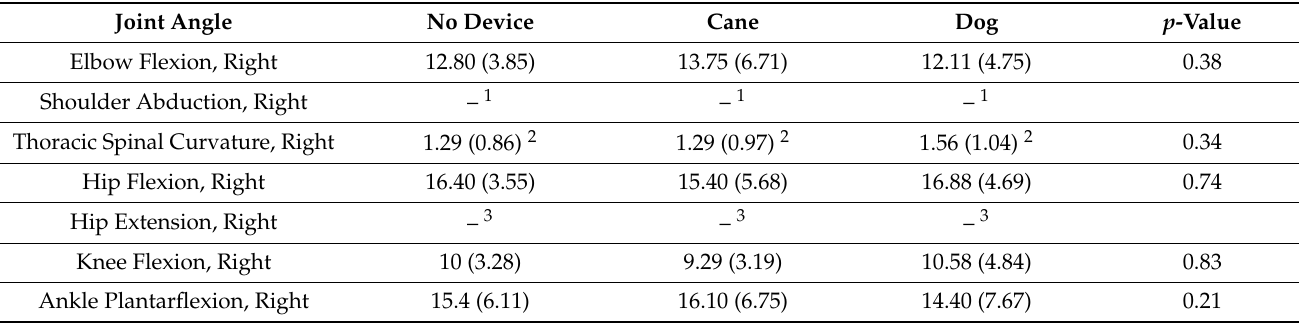
Table 1. Mean and standard deviation of specified joint angles for all participants under each condition, measured in degrees, and calculated p -values obtained from Friedman’s test, for right side.